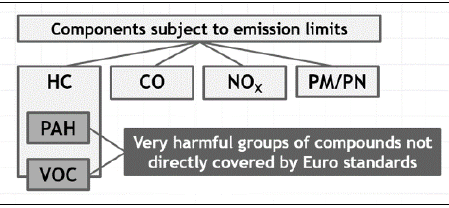
Fig. 1. Location of VOCs and PAHs among the limited components of exhaust gases